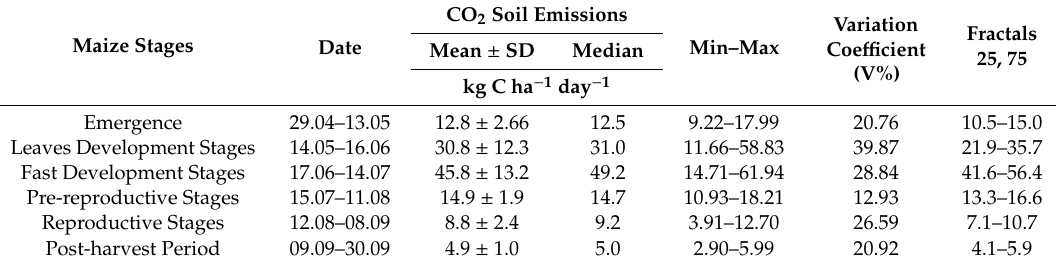
Figure 5. Relationship between the variations in the soil respiration and: NO 3 − -N content ( a ); NH 4 + -N soil content ( b ); atmospheric temperature (T a ) ( c ); and soil moisture (WFPS) ( d ). * p < 0.05. Table 3. Daily CO 2 -C soil emissions during four essential periods of maize